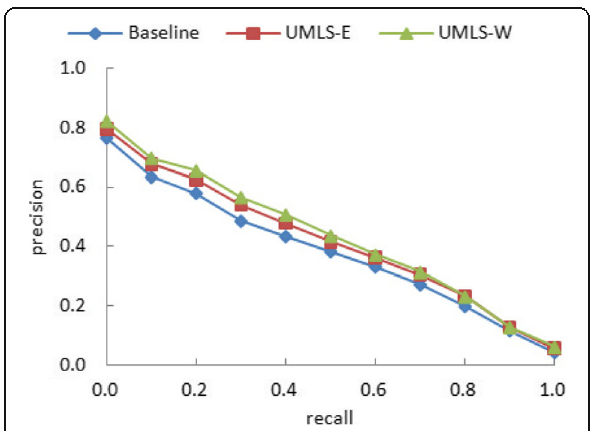
Fig. 5 The precision and recall of Baseline, UMLS-E, and UMLS-W